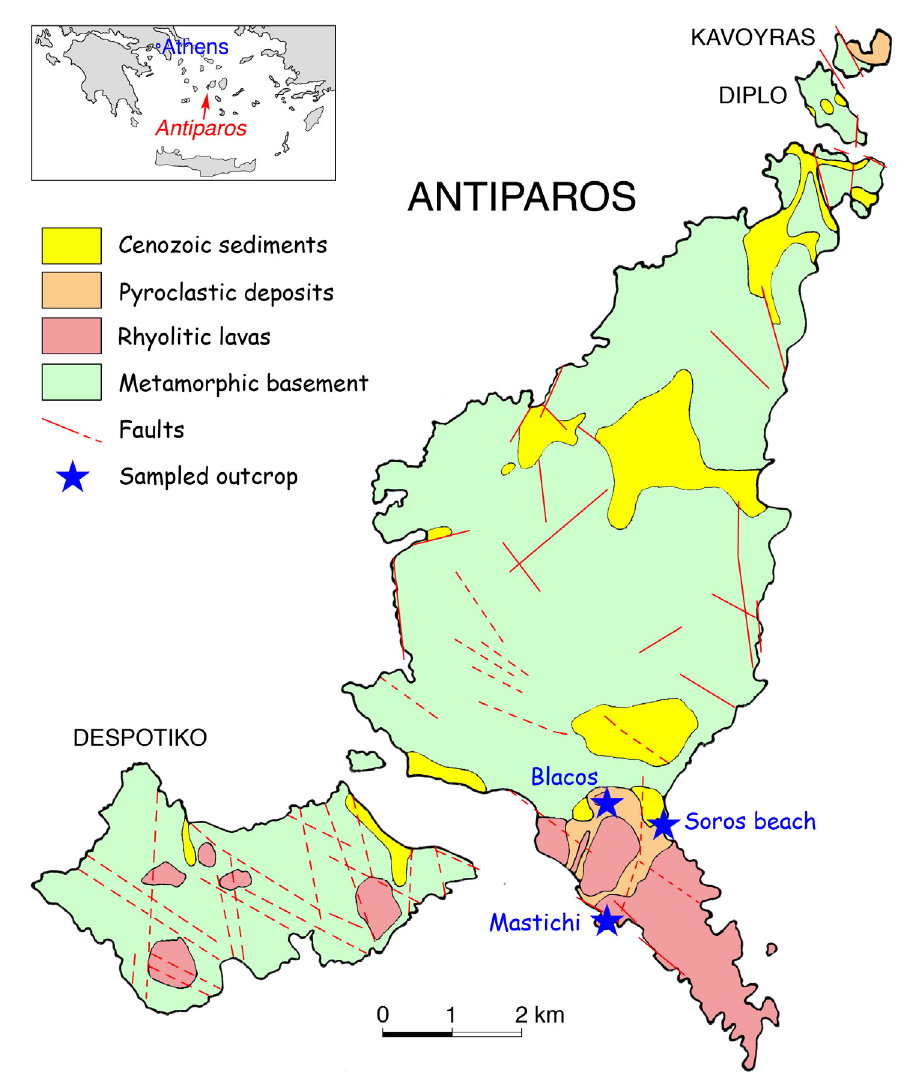
Figure 2. Simplified geological map of Antiparos island (from Innocenti et al., 1982,